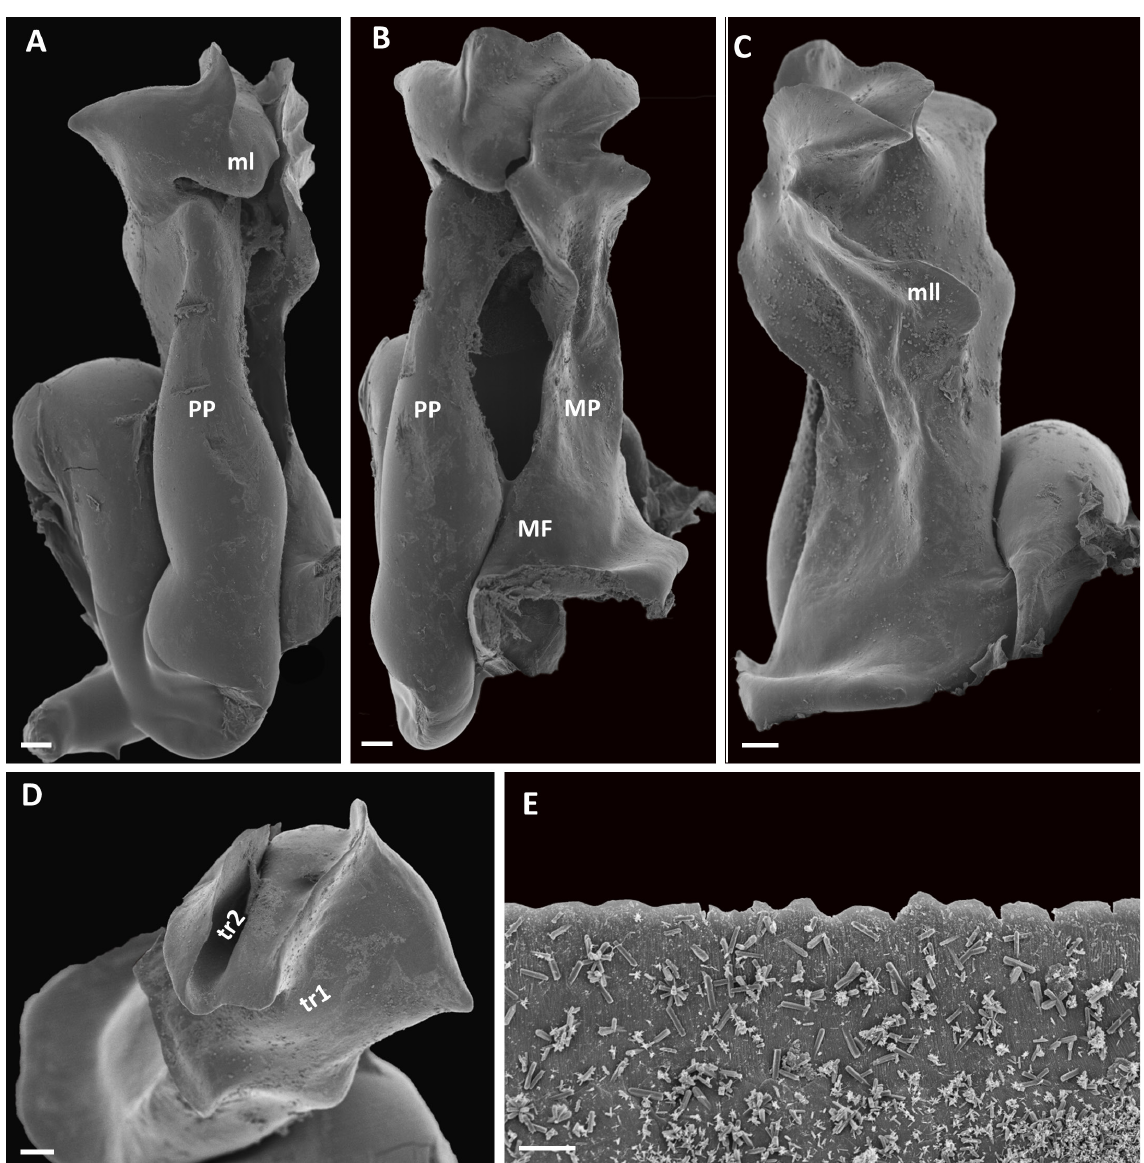
Fig. 41. Lamelloramus frederiksenae sp. nov., holotype, ♂ (NHMD 621744). A–D . Left gonopod coxa. A. Anterior view. B. Mesal view. C. Posterior view. D. Distal view (lateral side to the right). E . Midbody dorsal limbus. Abbreviations: MF = metaplical flange; ml = metaplical lobe; mll = metaplical lateral lobe; MP = metaplica; PP = proplica; tr1 , tr2 = apical metaplical troughs. Scale bars: A–D = 0.1 mm; E = 0.01